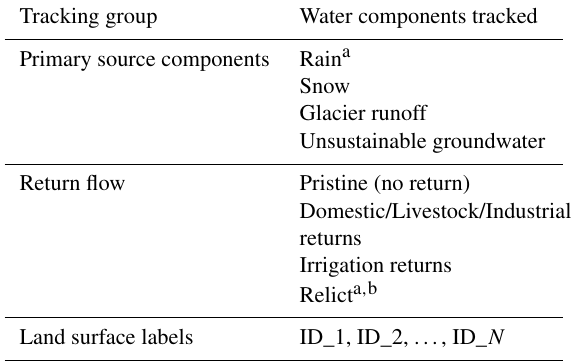
Table 3. Tracking component categories, and the identification of the water source components